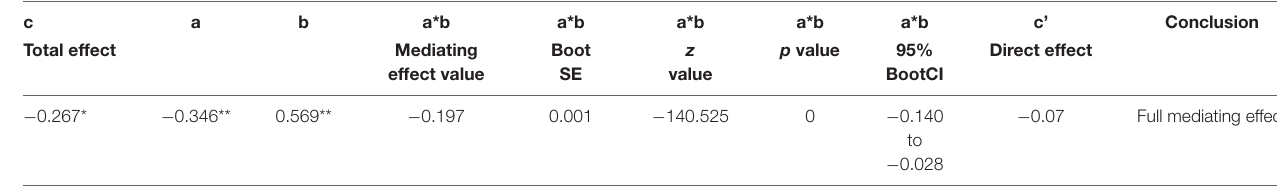
TABLE 4 | Bootstrap sampling method.